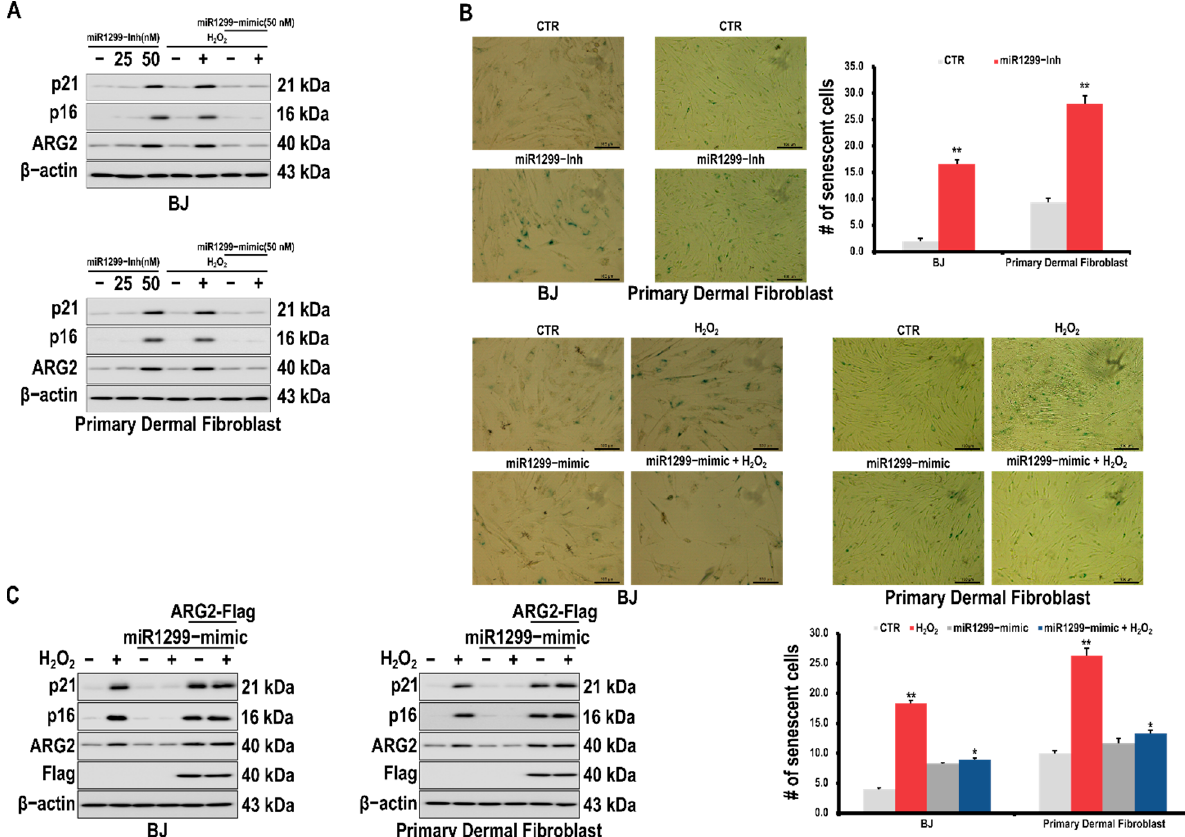
Figure 3. Effects of miR-1299 on the senescence of skin fibroblast cells. ( A ) Effect of the miR-1299 inhibitor and miR-1299 mimic on the expressions of cellular senescence markers, p16 and p21, in skin fibroblasts. Cells were transfected with an miR-1299 inhibitor and treated with H 2 O 2 (200 µ M) for 24 h after transfection. ( B ) Representative images indicating senescence-associated β -galactosidase in cells transfected with the miR-1299 inhibitor (left) or H 2 O 2 –induced skin fibroblasts transfected with an miR-1299 mimic (right). ( C ) Effect of restoring ARG2 expression on the senescence of skin fibroblasts transfected with miR-1299. Cells were transfected with an miR-1299 mimic and treated with H 2 O 2 for 24 h after transfection and subsequently transfected with an ARG2 plasmid again. The protein levels were investigated using Western blotting. # represents the number of senescent cells. A * p value < 0.05 and ** p value < 0.01 were considered statistically significant and error bars represent ± SD.